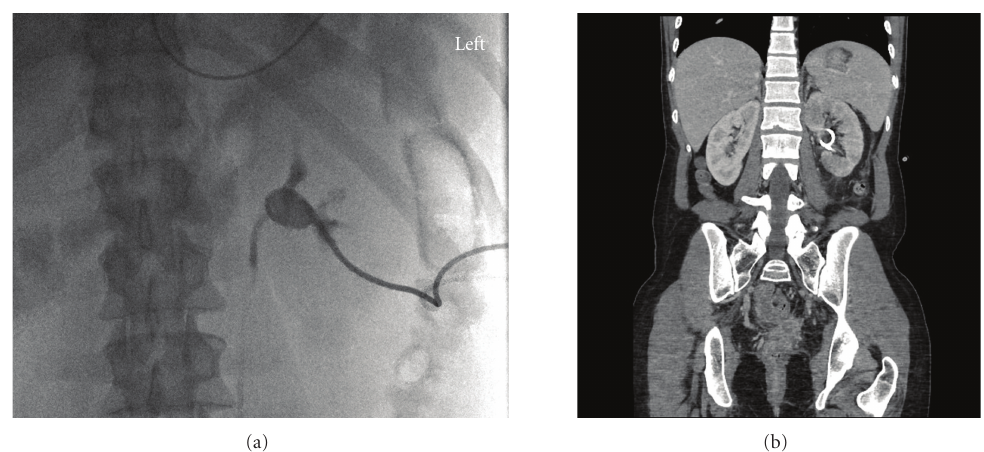
Figure 4: 21-year-old woman with cervical cancer develops ureteric obstruction due to local disease invasion. (a) Contrast injection immediately following percutaneous nephrostomy confirms 8 french catheter in good position within renal collecting system. (b) Contrast- enhanced CT scan confirms percutaneous nephrostomy catheter in positioned within left renal collecting system. Patient is post total abdominal hysterectomy and bilateral